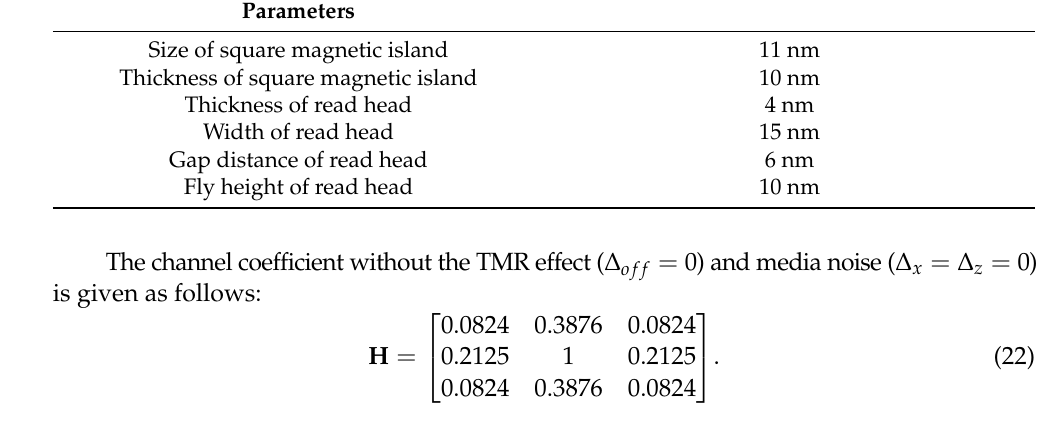
Table 3. Physical parameters. Parameters Size of square magnetic island 11 nm Thickness of square magnetic